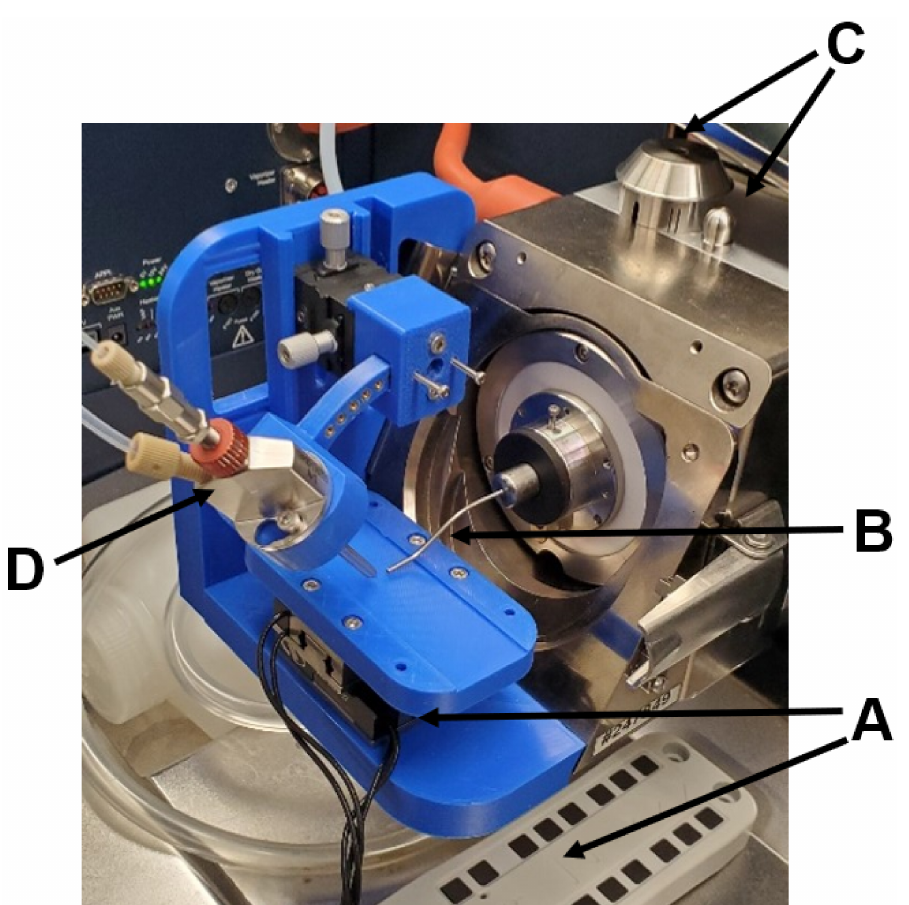
Figure 6. Photograph of the sourced mounted on the mass spectrometer, highlighting the Agilis LS-25-27 array and UC2 controller ( A ), the capillary extension and nanospray gas diverter ( B ), the removed endplate and capillary nub ( C ), and the standard sprayer electrospray emitter ( D